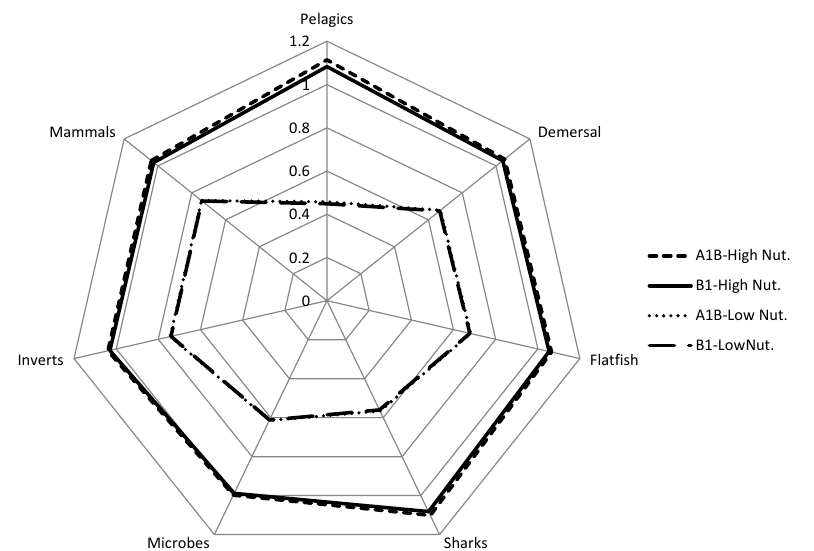
Figure 5. Changes in relative biomass of seven classes of functional groups under differing conditions of warming and nutrient availability (see Table 2 for